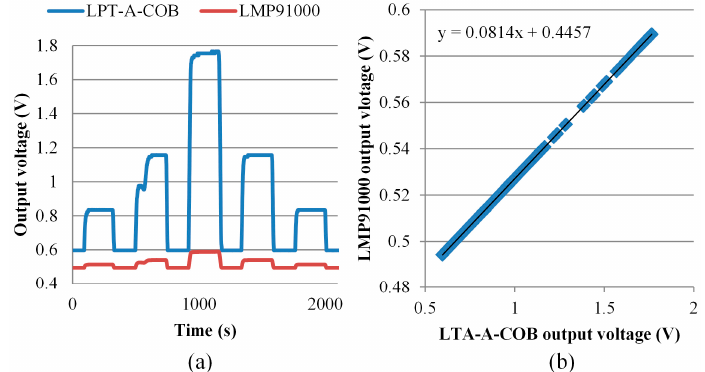
Figure 9. ( a ) Dynamic response curves of the output voltage of the COSWOB and the LPT-A-COB versus time for CO concentrations ranging from 25 to 1000 ppm; ( b ) Linear regression of the relationship between the COSWOB and the LPT-A-COB.